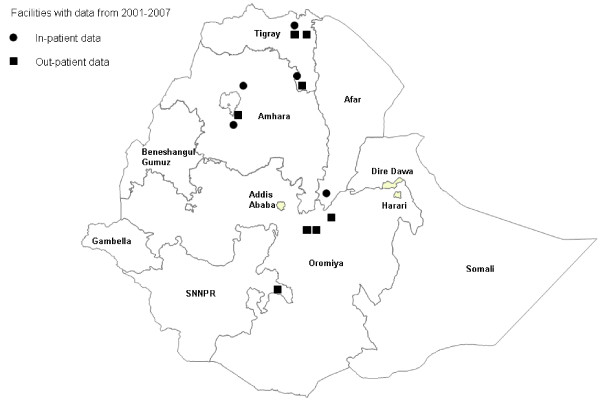
Location of hospitals and health centers that were selected for data collection and had complete data for 2001–2007, November 2007, Ethiopia.